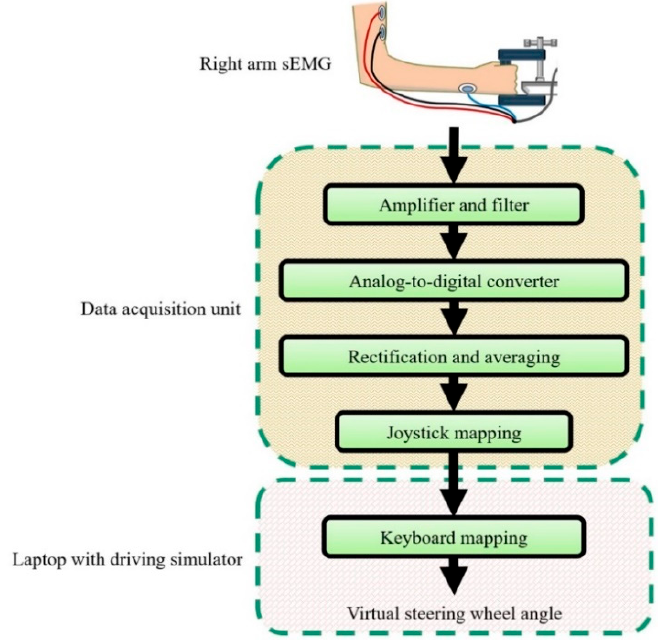
Figure 6. Steering assistance control system for driving simulator.